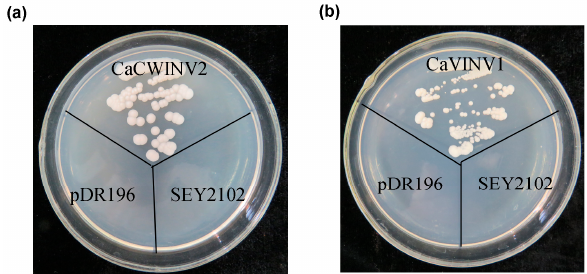
Figure 9. Growth of invertase-deficient strain SEY2102 transformed by pDR196- CaCWINV2 ( a ) and pDR196- CaVINV1 ( b ) on selective plates containing sucrose as the sole carbon source at 28 °C for 4 days. SEY2102 yeast cells transformed with empty pDR196 vector were used as control.